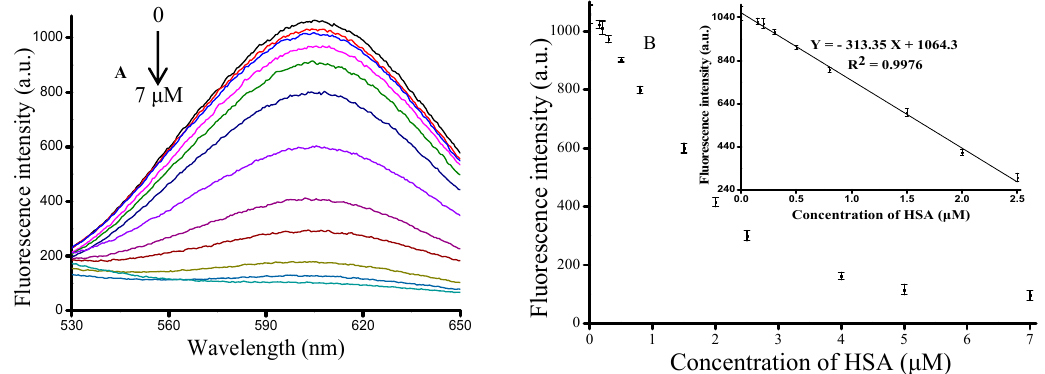
Figure 3. ( A ) Fluorescence emission spectra of the concentration of HSA (0, 0.15, 0.2, 0.3, 0.5, 0.8, 1.5, 2, 2.5, 4, 7 µM). Optimized assay conditions were used; ( B ) Graph depicting the changes in fluorescence output at 610 nm as a function of HSA concentration. Inset: Linear relationship between fluorescence intensity and low HSA concentrations. Error bars were estimated from three replicate measurements.